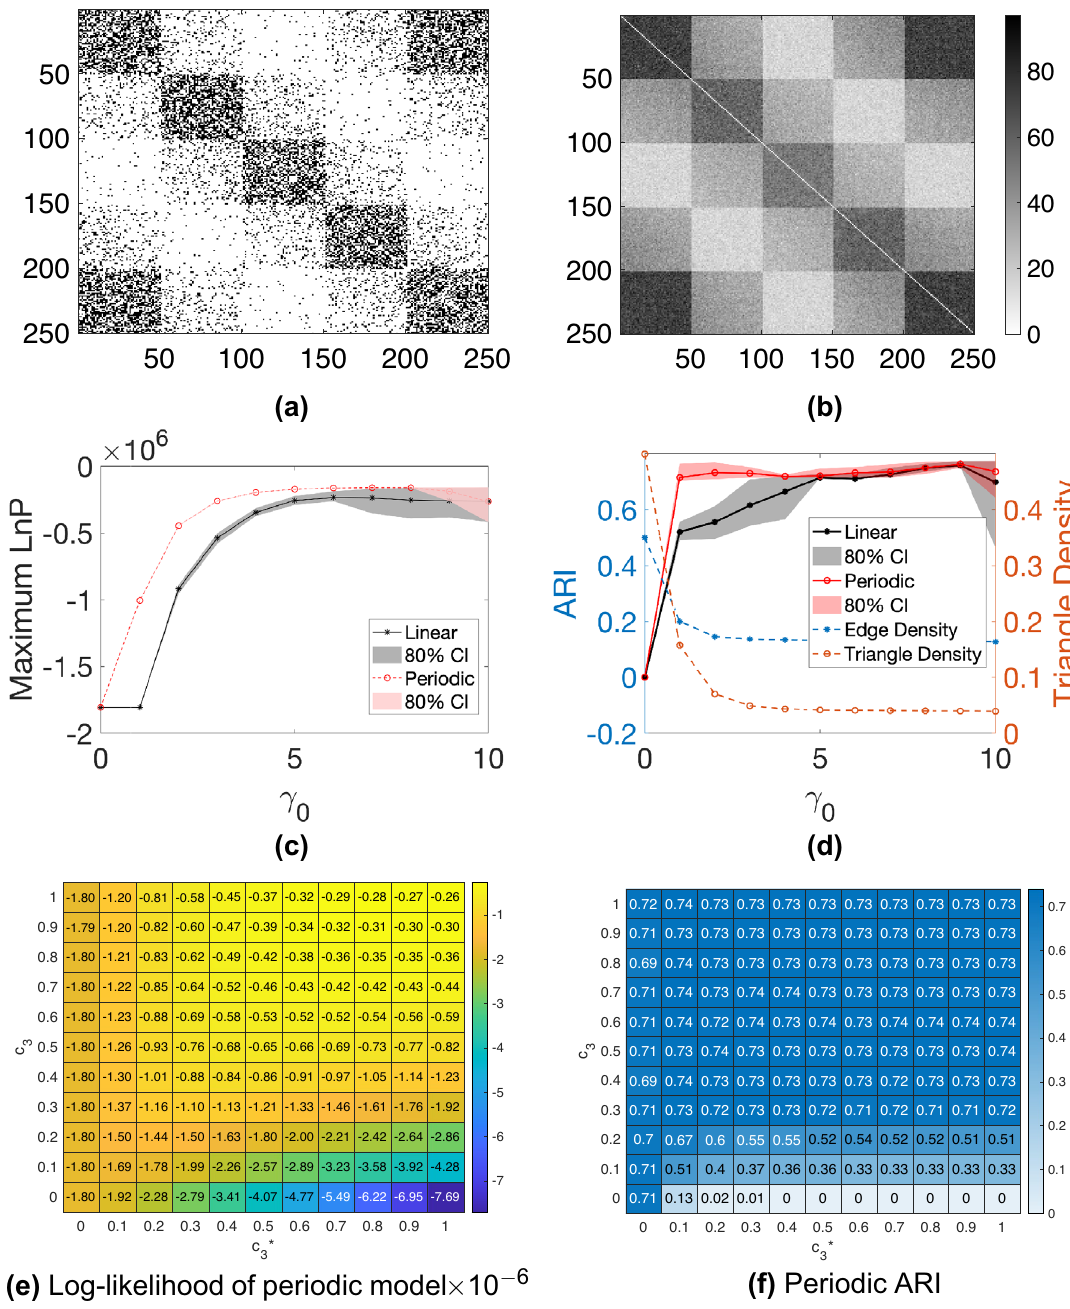
Figure 2. Model comparison experiments on synthetic periodic hypergraphs. ( a ) The bottom-left and top- 1 ) reveal a periodic clustered structure. ( b ) Similar periodic right blocks in the dyadic adjacency matrix ( γ 0 = 1 ). ( c ) The periodic embedding achieves higher clustered pattern is shown in the triadic adjacency matrix ( γ 0 = log-likelihoods than the linear embedding for different values of γ 0 . ( d ) Adjusted Rand Indices of K-means clustering based on the linear and periodic embedding are plotted against γ 0 . ( e ) Values in the heatmap indicate 6 10 the maximum likelihoods of the periodic model from Algorithm 3 and the maxima lie on the diagonal − × c 3 . ( f ) Values represent the Adjusted Rand Indices of K-means clustering based on the periodic where c ∗ 3 = embedding for different values of c ∗ 3 and c 3